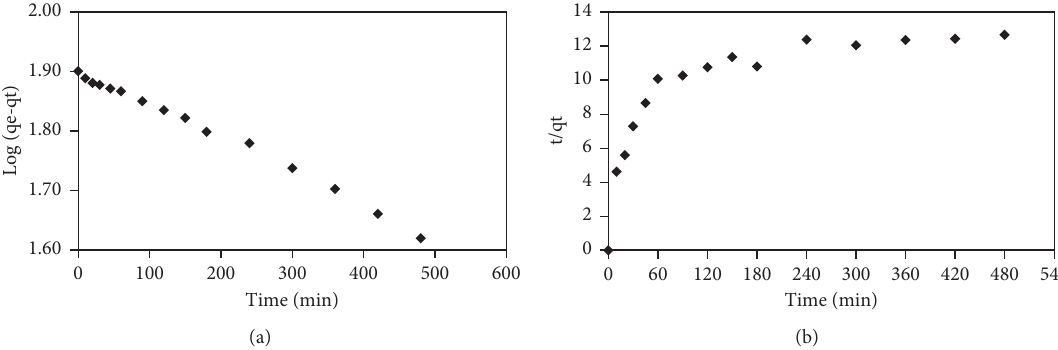
Figure 9: Pseudo-first-order plot (a) and pseudo-second-order plot (b) for the adsorption of MO onto cross-linked chitosan beads.